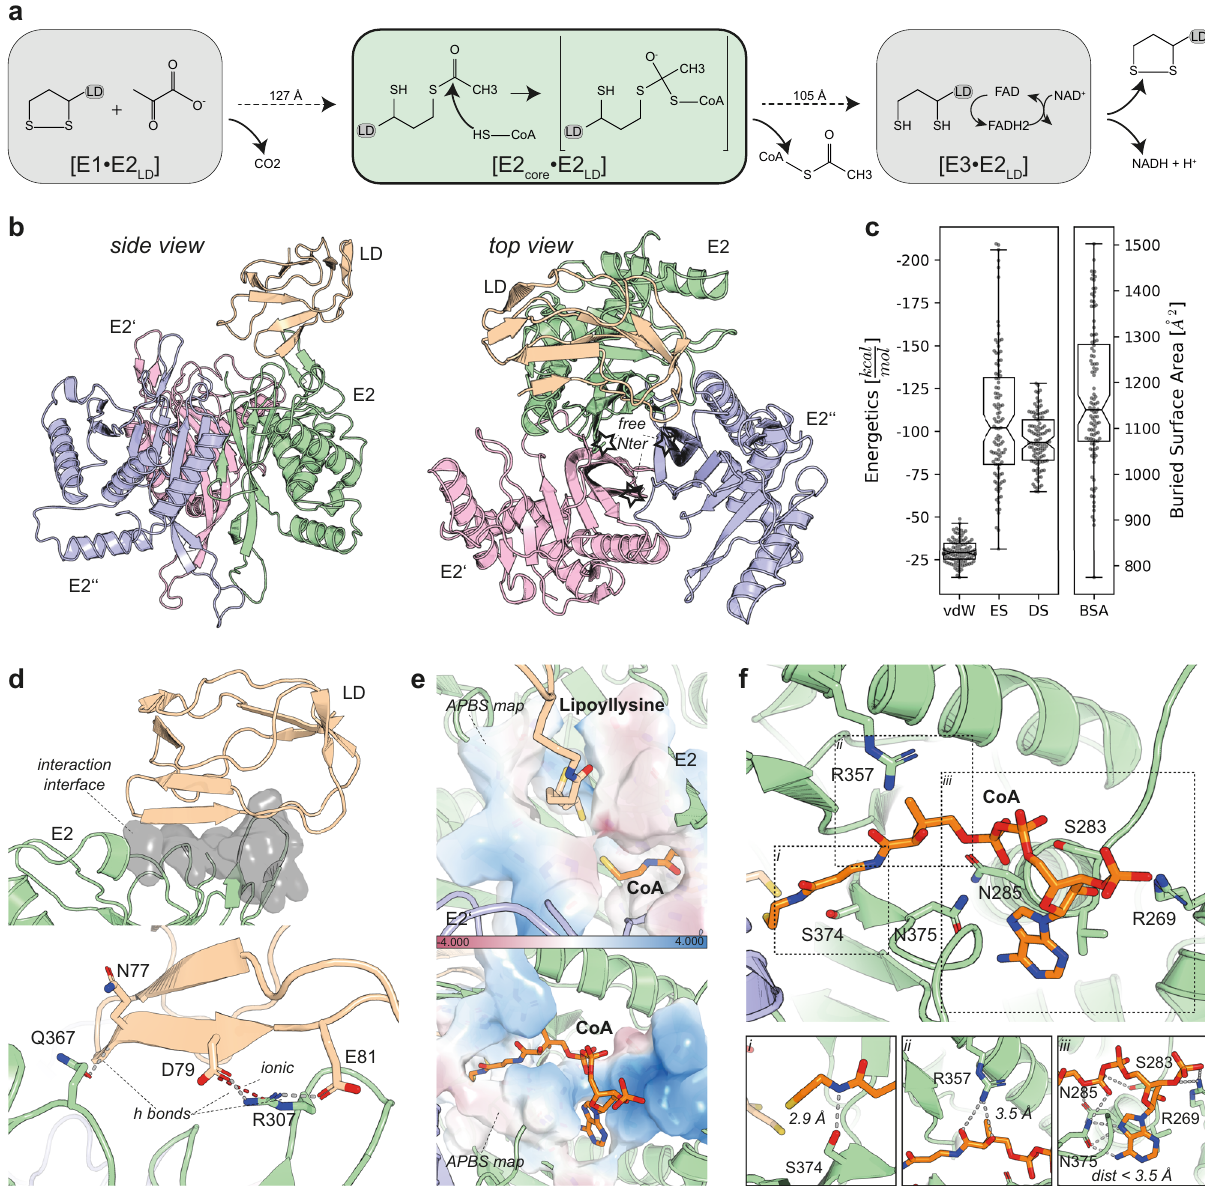
Fig. 5 Structure-based analysis of the transacetylase reaction within the PDHc core scaffold. a Schematic representation of the reaction steps implicating the lipoate moiety of the LD in the complete pyruvate oxidation reaction. The focus is on the highly transient E2 – LD interaction. b Top-scoring solution from the top-scoring cluster derived from the docking simulations (Supplementary Fig. 9) that included the LD and the E2 core. The N-ter ( ☆ ) of all three E2s is freely accessible in the derived docking model. c HADDOCK energetics of the selected cluster, containing n = 104 models. Binding is mainly mediated by ES and DS, while vdW contribution is decreased. The box minima represent the 25th percentile, the box maxima the 75th percentile, the Notch indicated the data ’ s median, whiskers extend to the minimum and maximum value inside of a 1.5 interquartile range. All data points are overlayed as a beeswarm plot. d Interaction interface between LD and E2. The interaction is stabilized by three H bonds and a very strong ionic interaction between the Arg307 of E2 and the Asp79 of LD. e Electrostatic surface potential maps of the two substrate-binding pockets in the active site. The lipoate binding pocket is overall uncharged, whereas the CoA binding pocket stabilizes the negatively charged phosphates. f Binding of the CoA in the active site. Inlets i – iii show the hydrogen-bonding networks stabilizing the complete molecule. The lipoate and CoA were derived from docking procedures and re fi ned during MD simulation (Supplementary Fig. 13, see